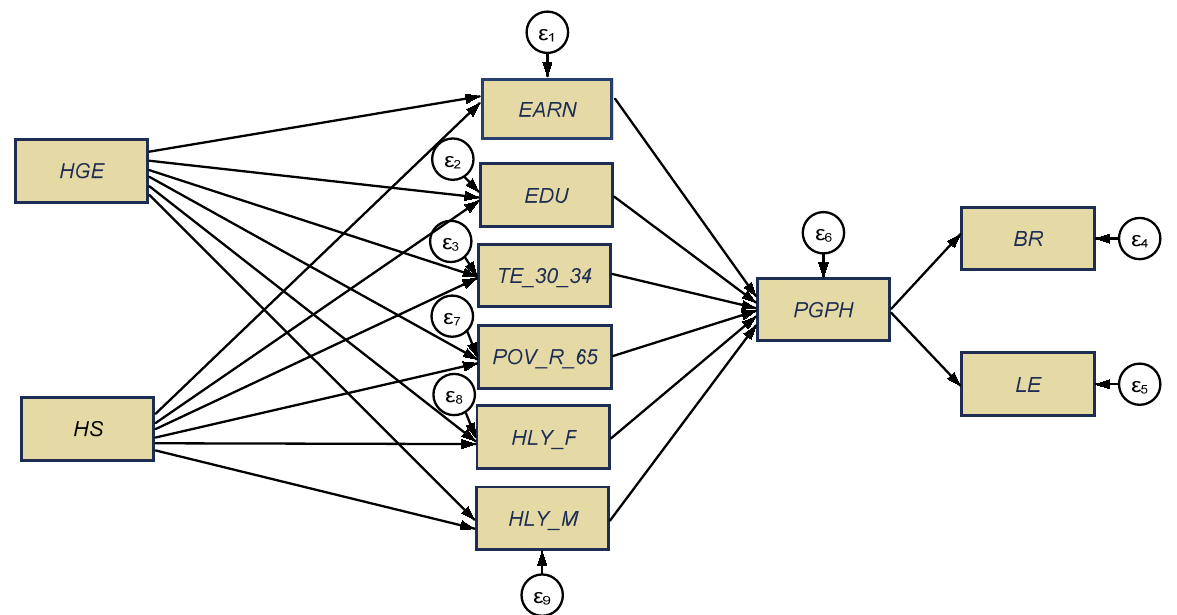
Figure 4. General configuration of health-aging interlinkages, structural equation modelling (SEM) model. Source: authors’ process in Stata 16 (StataCorp LLC, Texas, TX, USA).